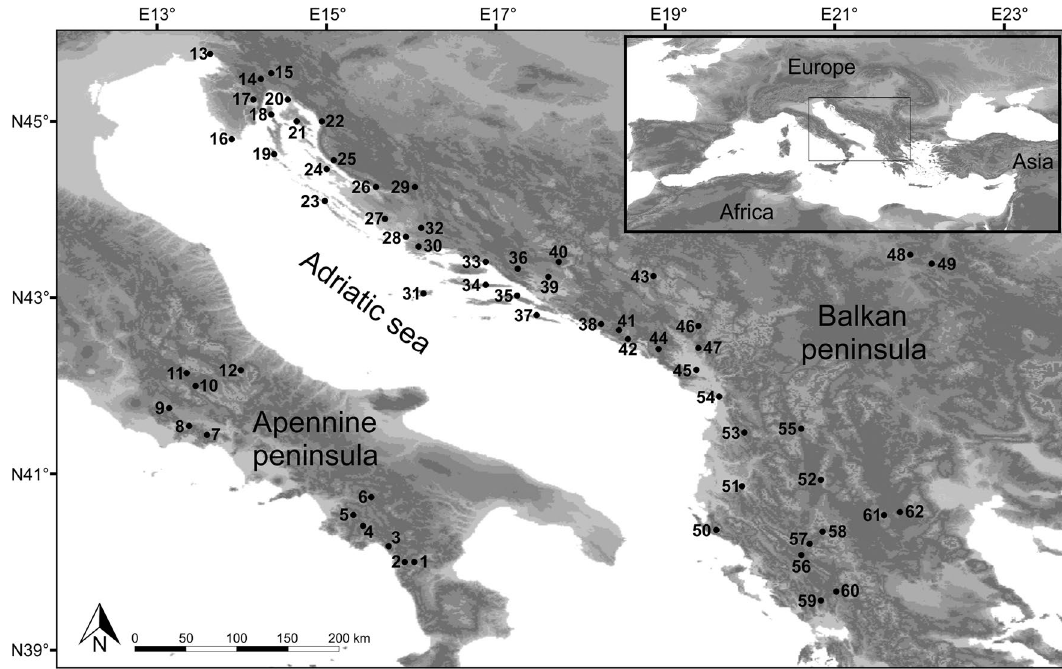
Figure 5. Sampling sites of the studied common sage ( Salvia officinalis L.) populations. The satellite imagery was obtained from Natural Earth public domain map dataset (https:// www. natur alear thdata. com/ downl oads/ 10m- raster- data/ 10m- gray- earth/). CorelDraw Graphics Suite X7 Version 17.1.0.572 (Corel Corp., Ottawa, Canada) was used to create the